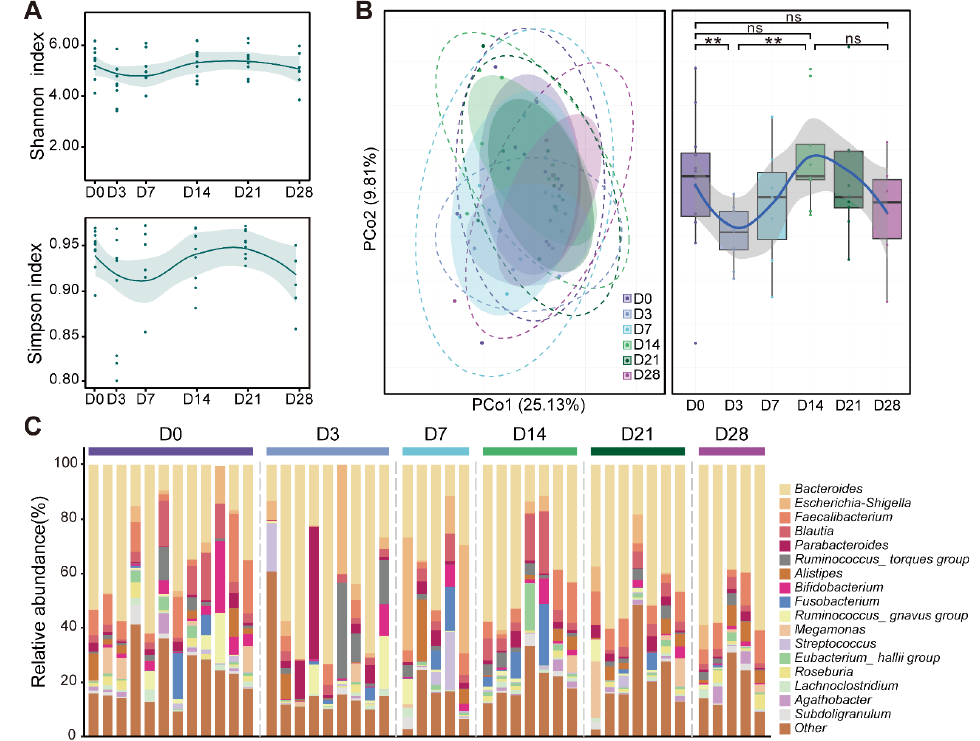
Figure 3. The structure of intestinal microbiota changed after bowel preparation. ( A ) The alpha diversity of the microbiota after bowel preparation over time. The top and bottom panels show the Shannon and Simpson indices of the microbiota, respectively. ( B ) Individual gut microbiota compositions draw a Bray-Curtis PCoA plot in different time groups (left panel). There are some differences in the composition of the flora at different times (right panel). Significance was measured using the Wilcoxon rank-sum test. Boxplot center values indicate the median value, error bars indicate the extreme value. The dotted ellipse borders represent the 95% confidence interval (CI), the shaded ellipses represent the 80% CI. ( C ) Percentage bar graph showing the relative proportion of bacterial genera in each sample. Curve fitting in all plots is conducted by the “LOESS” method. The shadow around the curve shows the 95% confidence interval. p > 0.05, ns (not significant, may not be indicated); ** p <